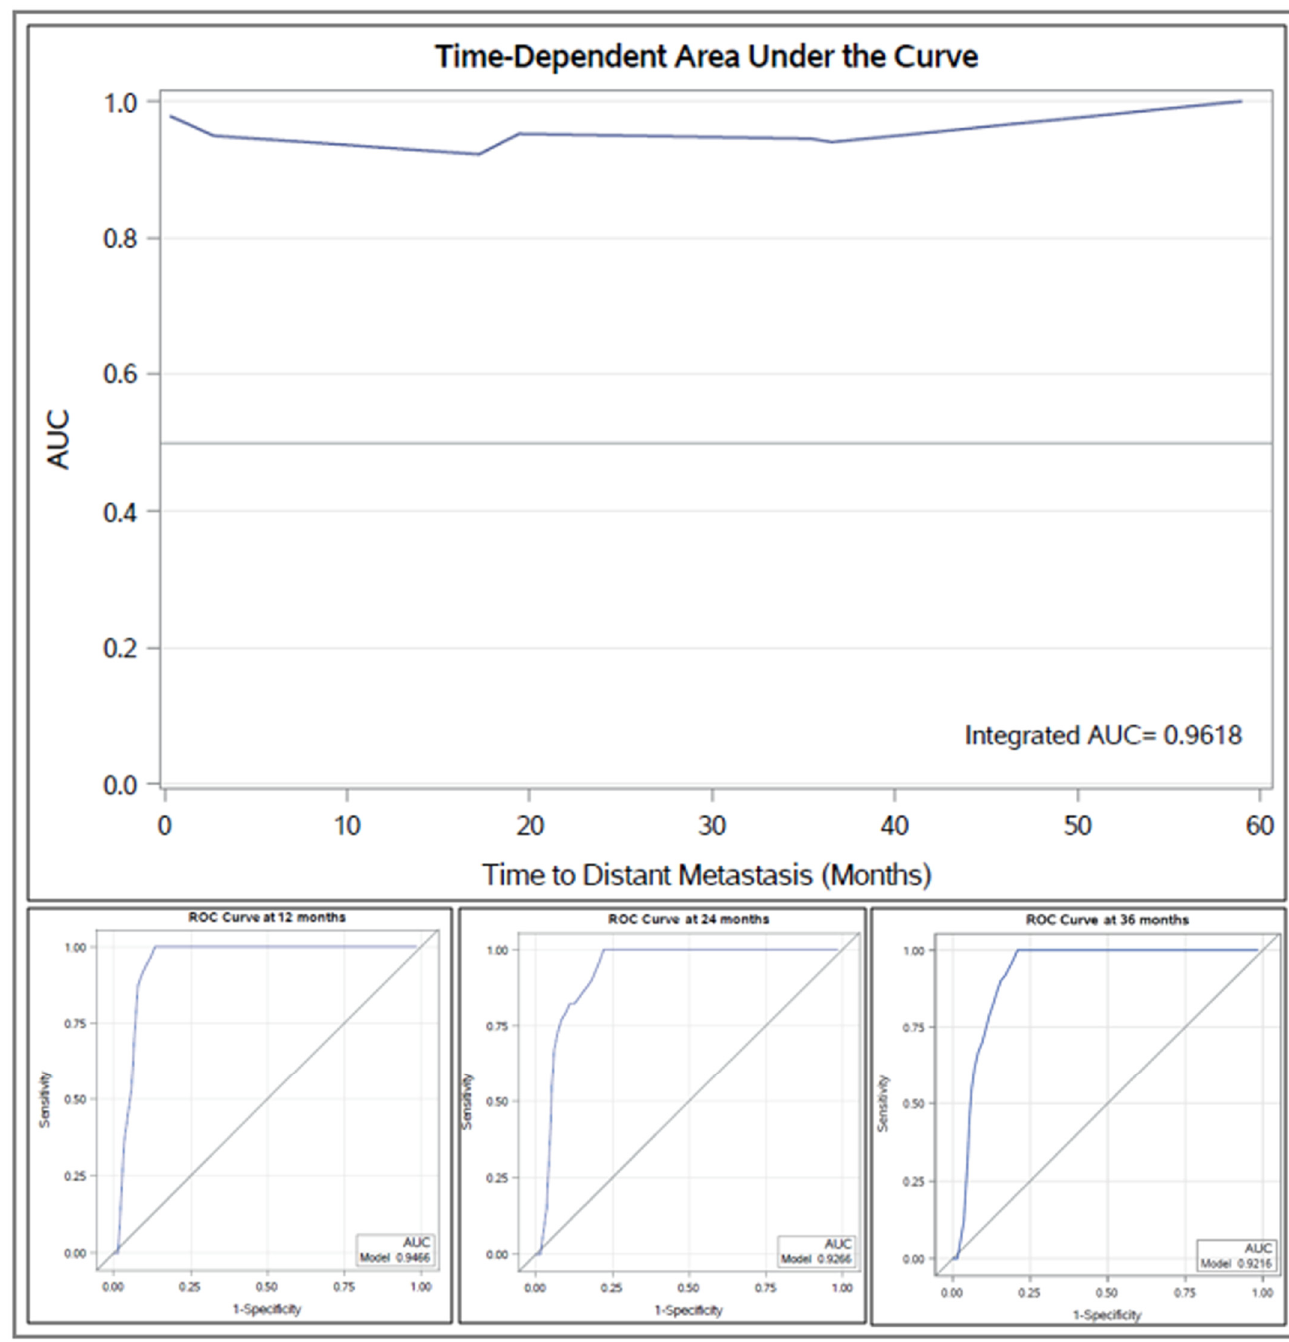
Figure 5. Time-dependent AUC for receiver operating characteristics (ROC) of multivariate model for distant metastasis is shown (top panel), including ROC curves at 1, 2, and 3 years (bottom panel). Abbreviations: AUC, Area under the curve; ROC, Receiver operating characteristics.